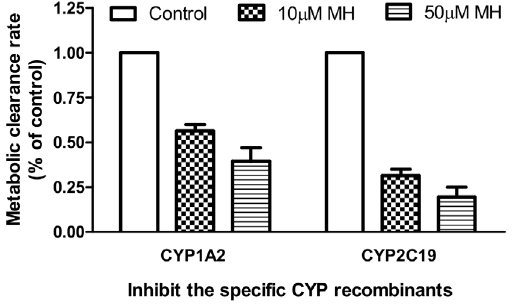
Figure 3. Effect on the metabolic clearance rate (MCR) of meranzin hydrate (MH) under the inhibition of recombinant CYP1A2 and CYP2C19. Note: 10 m M and 50 m M MH were incubated with the CYP recombinants and cofactors in the absence (control) or presence of the inhibitors by furafylline (1 m M) and ticlopidine (1 m M), respectively. Each point represents the average of triplicate incubations. The MCRs of MH were significantly decreased compared with that of the control for CYP1A2 and CYP2C19, for both concentrations of MH.